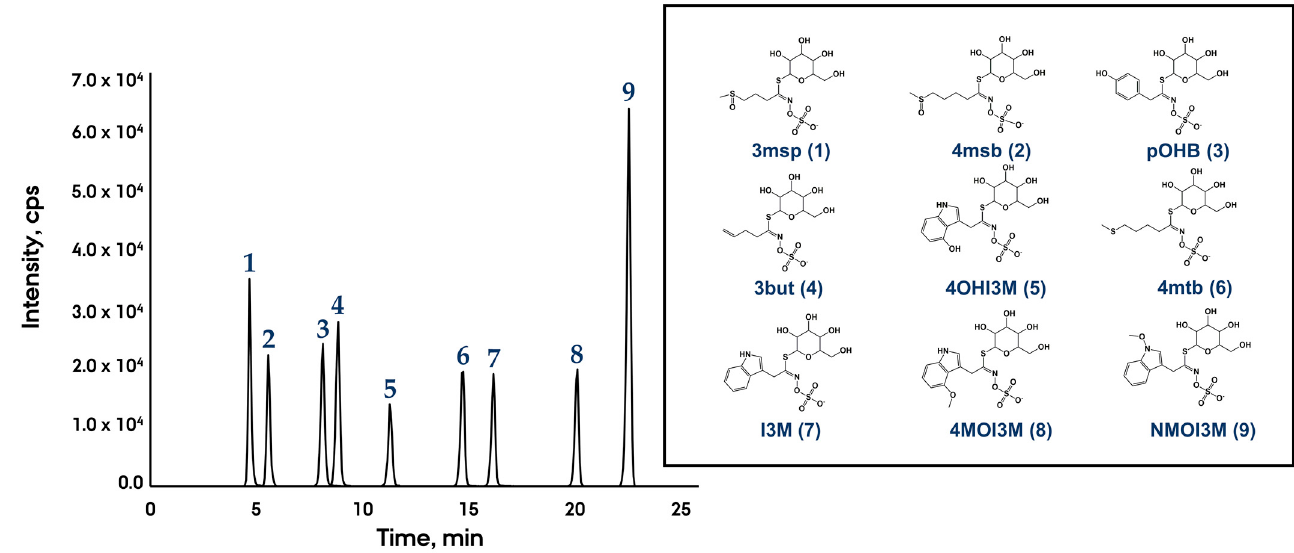
Figure 2. Chromatogram displaying the separation of intact glucosinolates with a variable side chain (100 ng/mL standard mixture) by liquid chromatography and detection by tandem mass spectrometry in multiple reaction monitoring (MRM) mode on a Synergi 4 µm Fusion-RP (250 × 2 mm) using MeOH/water with 0.1% acetic acid as solvent system. Sinalbin (pOHB) was used as an internal standard. The numbers on top of the chromatogram correspond to their associated structures, which are displayed on the right side of the chromatogram. Full names and abbreviations: glucoiberin (3msp), glucoraphanin (4msb), sinalbin (pOHB), gluconapin (3but), 4-hydroxyglucobrassicin (4OHI3M), glucoerucin (4mtb), glucobrassicin (I3M), 4-methoxyglucobrassicin (4MOI3M) and neoglucobrassicin (NMOI3M). 3msp, 3but, 4msb and 4mtb are aliphatic glucosinolates, while I3M, 4OHI3M, 4MOI3M and NMOI3M are indole glucosinolates.